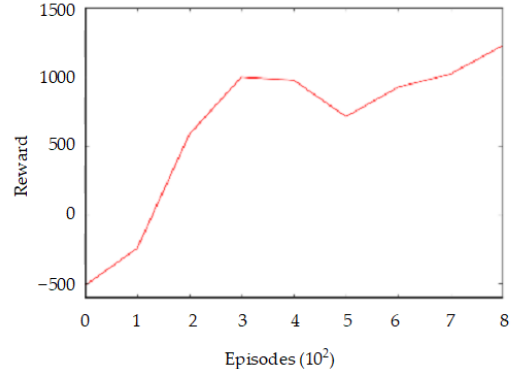
Figure 15. Average cumulative reward obtained by a DDQN agent in the Gazebo simulator.